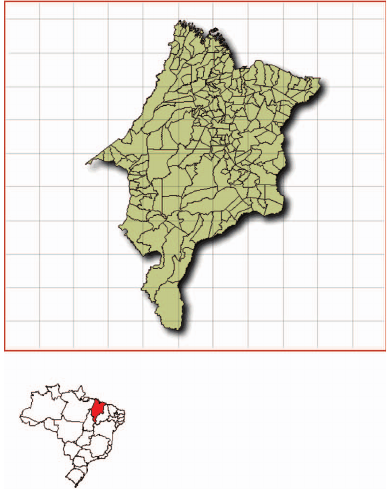
Figure 1 - Buriticu and the State of Maranhão in a map of Brazil. Figura 1 - Localização do Município de Buriticupu, Maranhão,